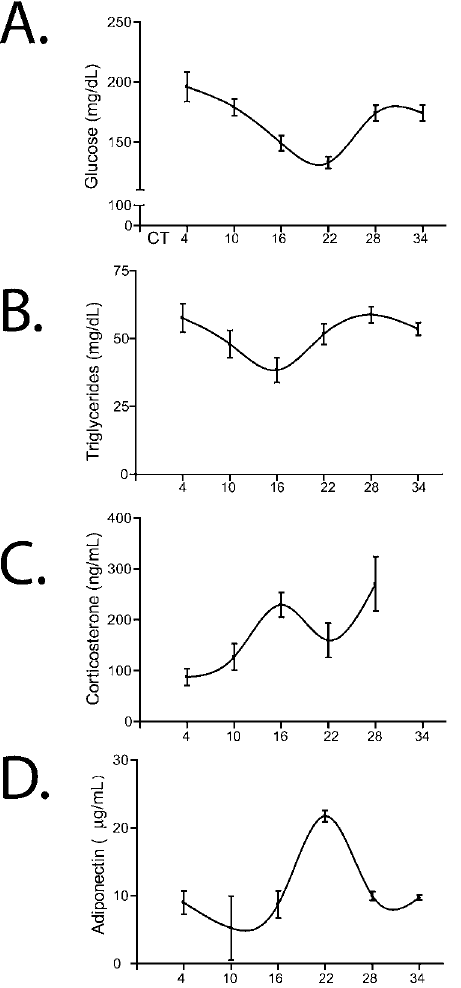
Figure 1. Circadian Variation of Glucose, Triglyceride, and Hormone Levels in Circulating Blood Plasma from whole blood isolated from unchallenged WT mice at different CTs was analyzed for glucose (A), triglyceride (B), cortico- sterone (C), and adiponectin levels (D) ( n ¼ 12 per time point). Results for Bmal1 (cid:1) / (cid:1) and Clock mut mice are shown in Table 1. DOI: